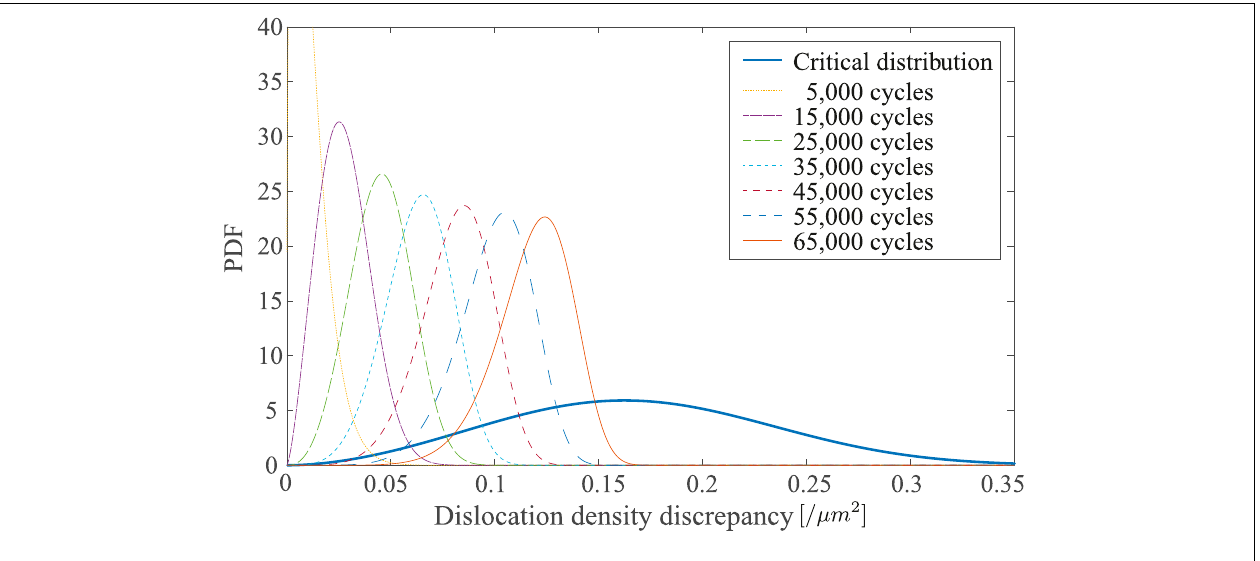
FIGURE 10 | Distribution of D 3 and critical D 3